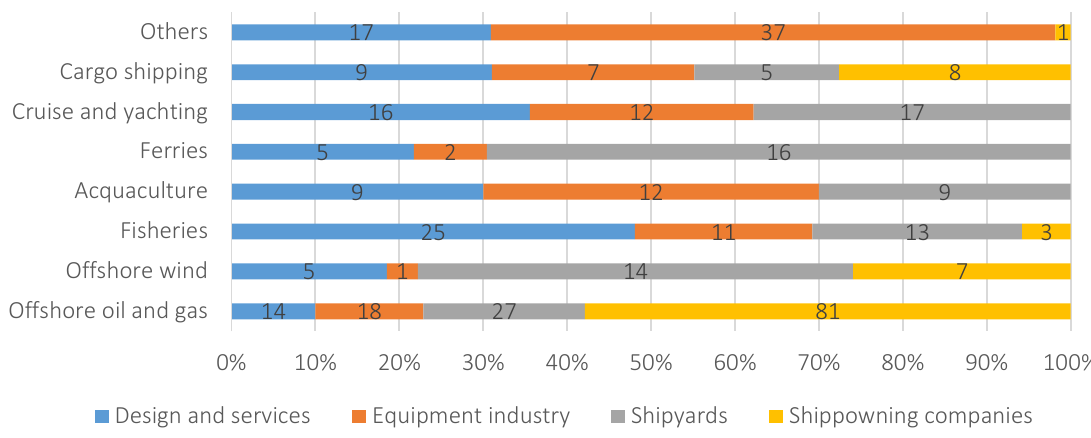
Figure 9. Turnover by markets 2017 as percentages for